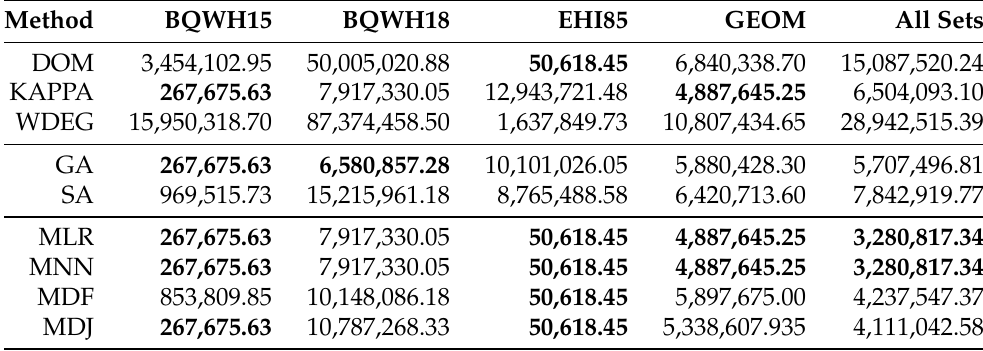
Figure 4. Boxplots of the consistency checks required by each method on the test set. Table 1. Average number of consistency checks for all heuristics and algorithm selectors, operating on the four test subsets of the benchmark instances (the best results are highlighted in